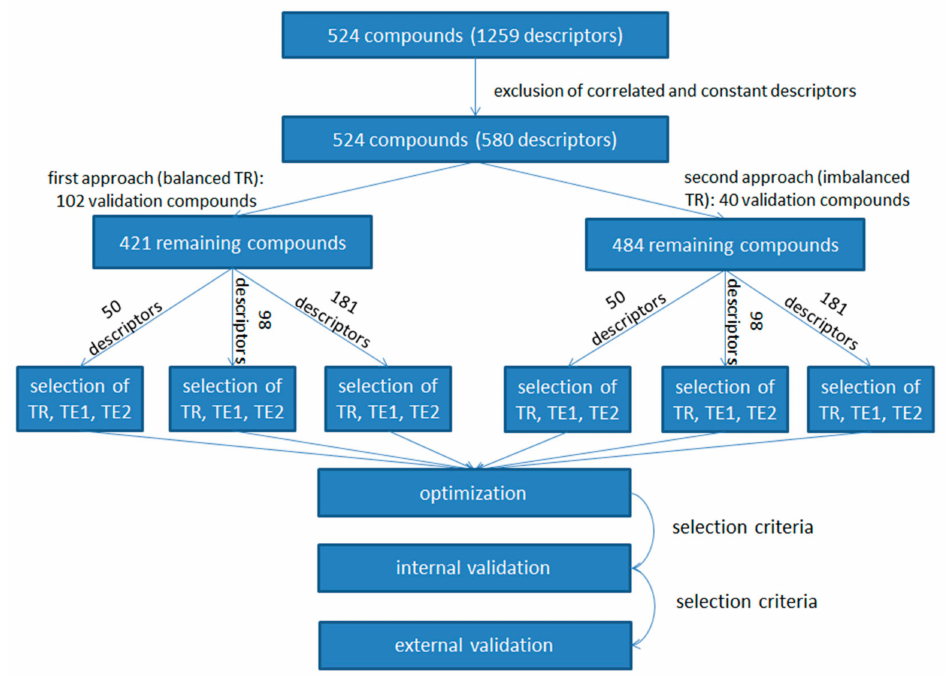
Figure 4. Modeling workflow. A total of 1259 Dragon descriptors were calculated for our dataset. The number of descriptors was reduced based on pairwise correlation and the frequency of the most common value. For the first modeling approach, where selection of the training set resulted in balanced classes, 102 validation objects were removed. For the second approach, where selection of the training set resulted in imbalanced classes, 40 objects were removed. For both approaches, the number of descriptors was further reduced: 50, 98, and 181 descriptors were selected. Based on the selected descriptors, objects for the training set (TR), test set 1 (TE1), and test set 2 (TE2) were